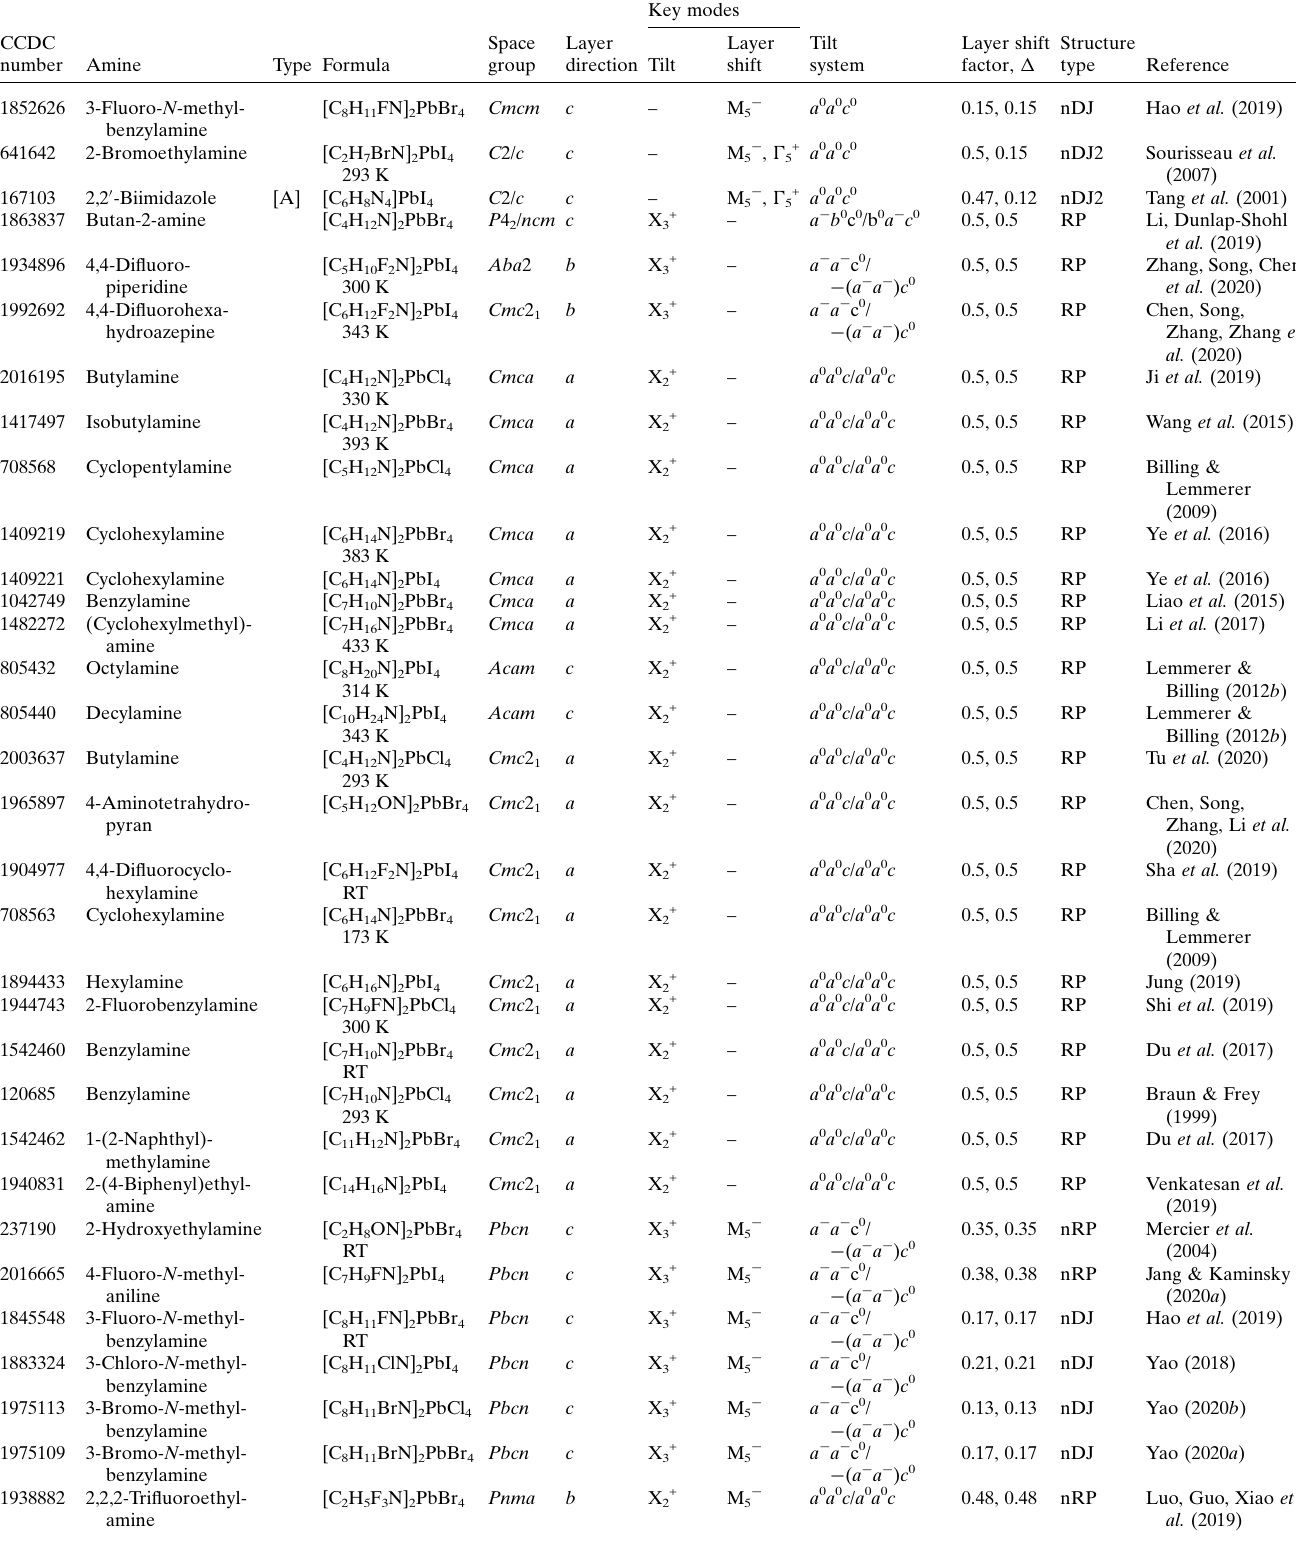
Table 2 Summary of experimentally known structures with two octahedral layers per unit cell (derived from RP parent, I 4/ mmm ) and ffiffiffi 2 metrics in the layer